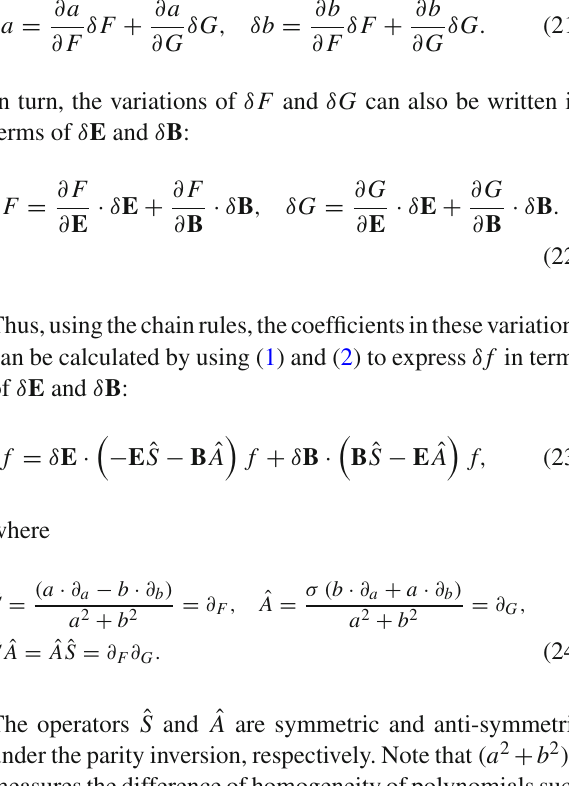
( ¯ a , ˜ b ) for n = 0 , 1 , 2 , 3 when (a) ˜ b = 0 . 2 and (b) ˜ b = 0 . 05. ¯ L ( 1 ) Fig. 5 ¯ L ( 1 ) exp ( ¯ a , ˜ b , n )/ ¯ L ( 1 ) int ¯ L ( 1 ) ( ¯ a , ˜ b ) is the numerical evaluation of (5) including the first 10 int